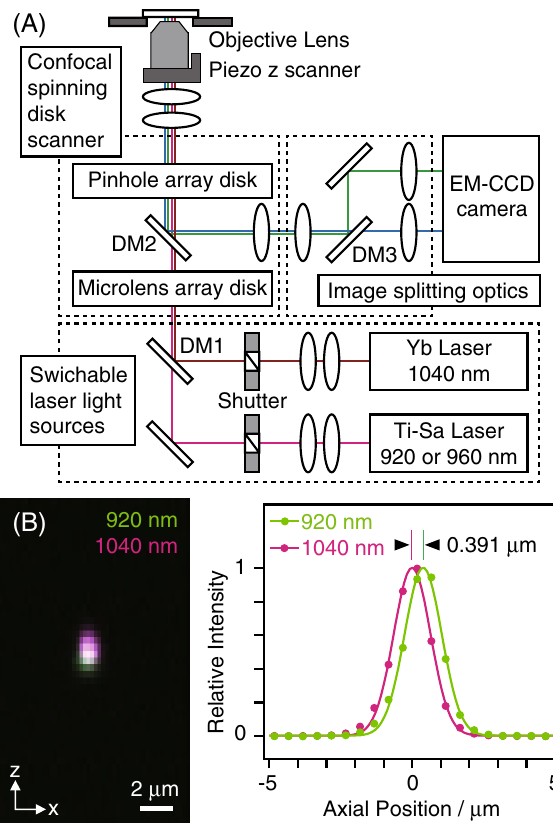
Figure 1. ( A ) Optical schematics of TPLM-SD with switching between two lasers and the use of image-splitting optics. ( B ) Chromatic aberration evaluation of the system between 920-nm and 1040-nm excitations. Merged 3D fluorescent images (Left panel) and axial fluorescent intensity profiles (Right panel) of a Nile Red-labeled bead of diameter 1